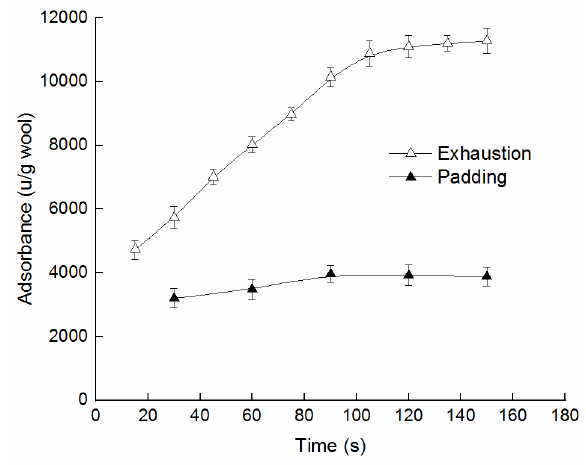
Figure 4. The adsorption of Savinase 16L with time in different treatments.